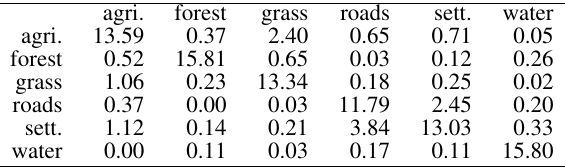
Table 1. Cross-validated confusion matrix of the simplified model as the average percentage over the holdout data from the 20 folds (overall accuracy: 0.83). agri. forest grass roads sett.